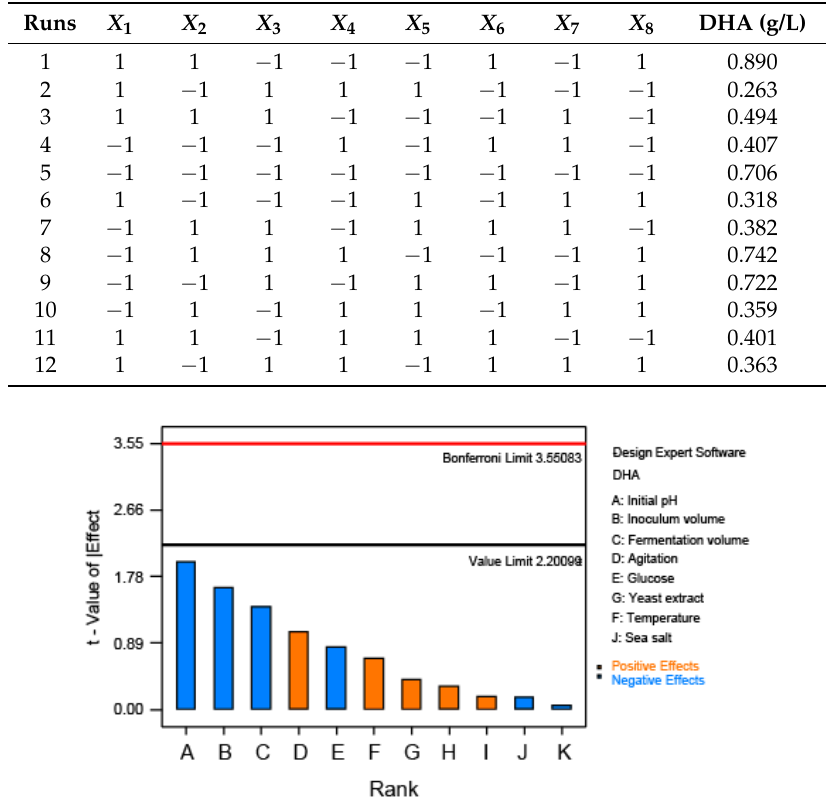
Table 2. Plackett-Burman design for screening variables (in coded level) with DHA production as the response.